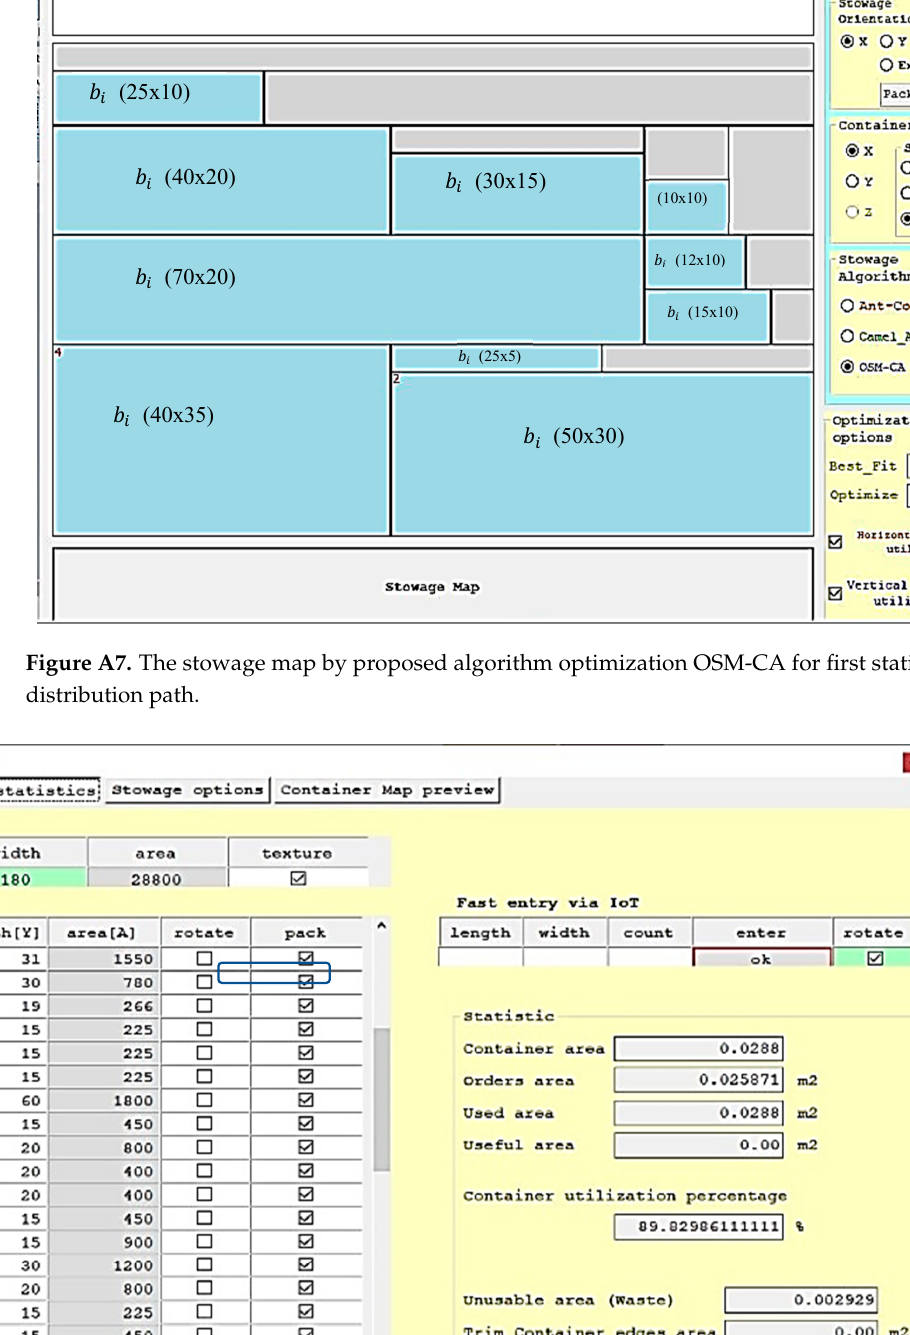
Figure A6. The container utilization by OSM-CA for first station on the distribution path.